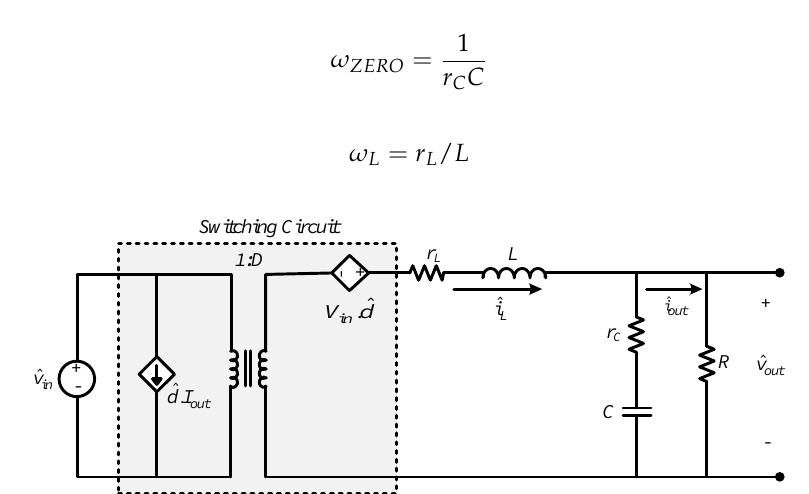
Figure 2. AC small-signal equivalent circuit for the buck converter power stage.